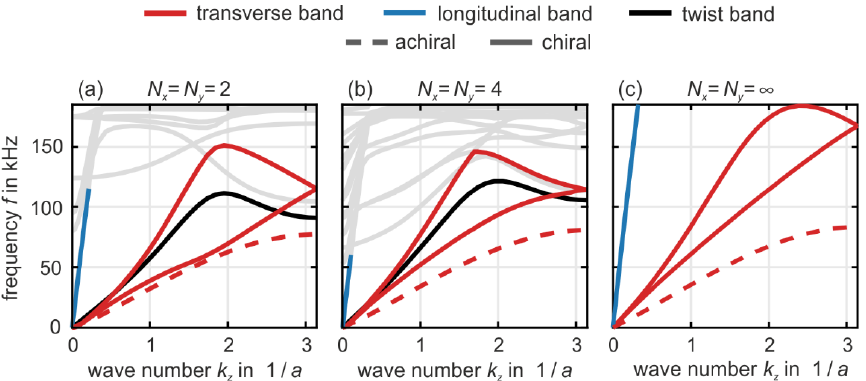
Figure 2. Calculated phonon band structures of metamaterial beams with a cross section of 𝑁 𝑥 × 𝑁 𝑦 unit cells in the 𝑥𝑦 -plane and with 𝑁 𝑧 = ∞ for wave vectors, 𝑘⃗ , along the 𝑧 -direction, i.e., 𝑘⃗ = (0,0, 𝑘 𝑧 ) with wave number 𝑘 𝑧 . ( a ) 𝑁 𝑥 = 𝑁 𝑦 = 2 , ( b ) 𝑁 𝑥 = 𝑁 𝑦 = 4 , and ( c ) bulk with 𝑁 𝑥 = 𝑁 𝑦 = ∞ . The transverse (or shear or flexural) bands are highlighted in red. Without chirality, the two transverse bands would be degenerate due to the four-fold rotational symmetry of the metamaterial crystal (see dashed red curves). The blue bands correspond to longitudinal-like (or pressure-like) and the black bands to twist-like modes, respectively. The higher bands are not important in the context of this paper and are plotted in light gray for clarity. Parameters have been given in Figure 1; the imaginary part of the polymer Young’s modulus is set to zero. In panel (a), the maximum splitting of the red bands , 𝛥𝑘 𝑧 , is about half of 𝜋/𝑎 , corresponding to a rotation angle of about 45° per lattice constant, which approach the fundamental bound of 90° per lattice constant.